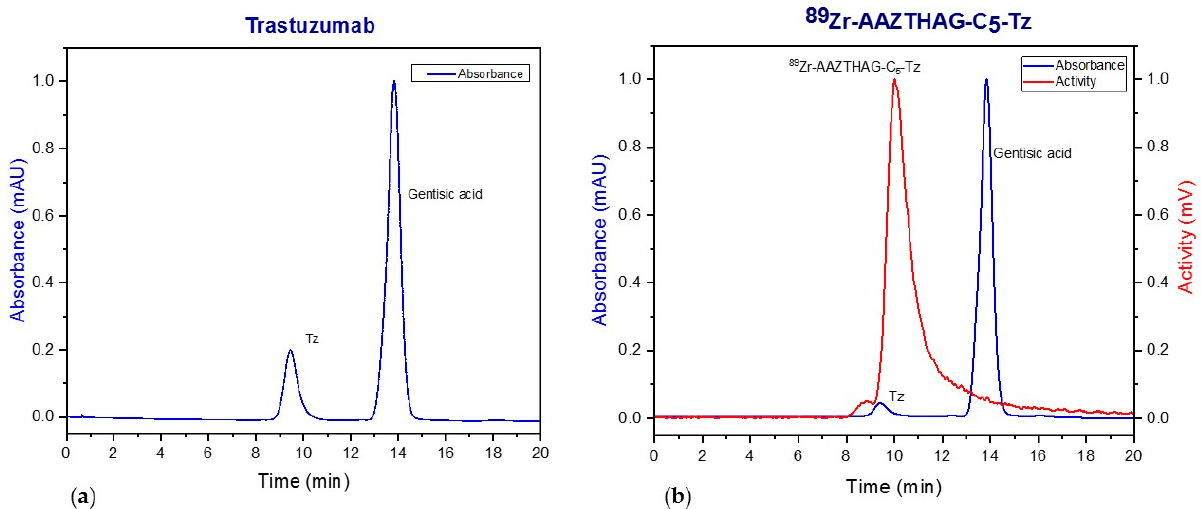
Figure 3. HPLC-SEC chromatogram of ( a ) Trastuzumab; ( b ) 89 Zr-AAZTHAG-C 5 -Tz. UV–Vis: tr = 9.40 min; activity: tr = 10.00 min, the peak with tr = 13.38 min is due to Gentisic acid present in the formulation buffer used for the purification of the product. The radioactivity peak has the same retention time as the UV–Vis peak (the small delay between the two peaks is due to the sequential setup of the UV and radioactive detectors), proving that the antibody is conjugated to the ligand and that 89 Zr is complexed by the ligand-antibody conjugate.